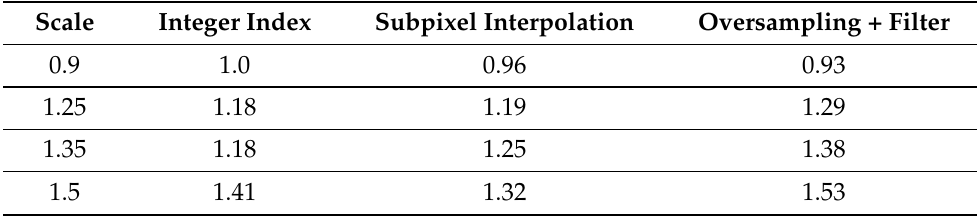
Table 1. Accuracy comparison of different methods for scale parameter determination. Although the signal information is very limited, the oversampled and filtered parameter determination achieves sufficient precise results for an object registration and subsequent identification.